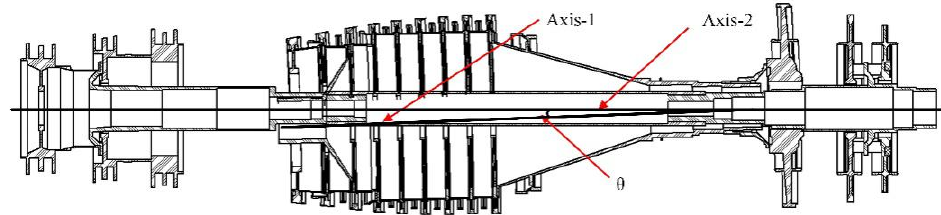
Figure 12. Rear deflection angle non-concentricity of dual-rotor.